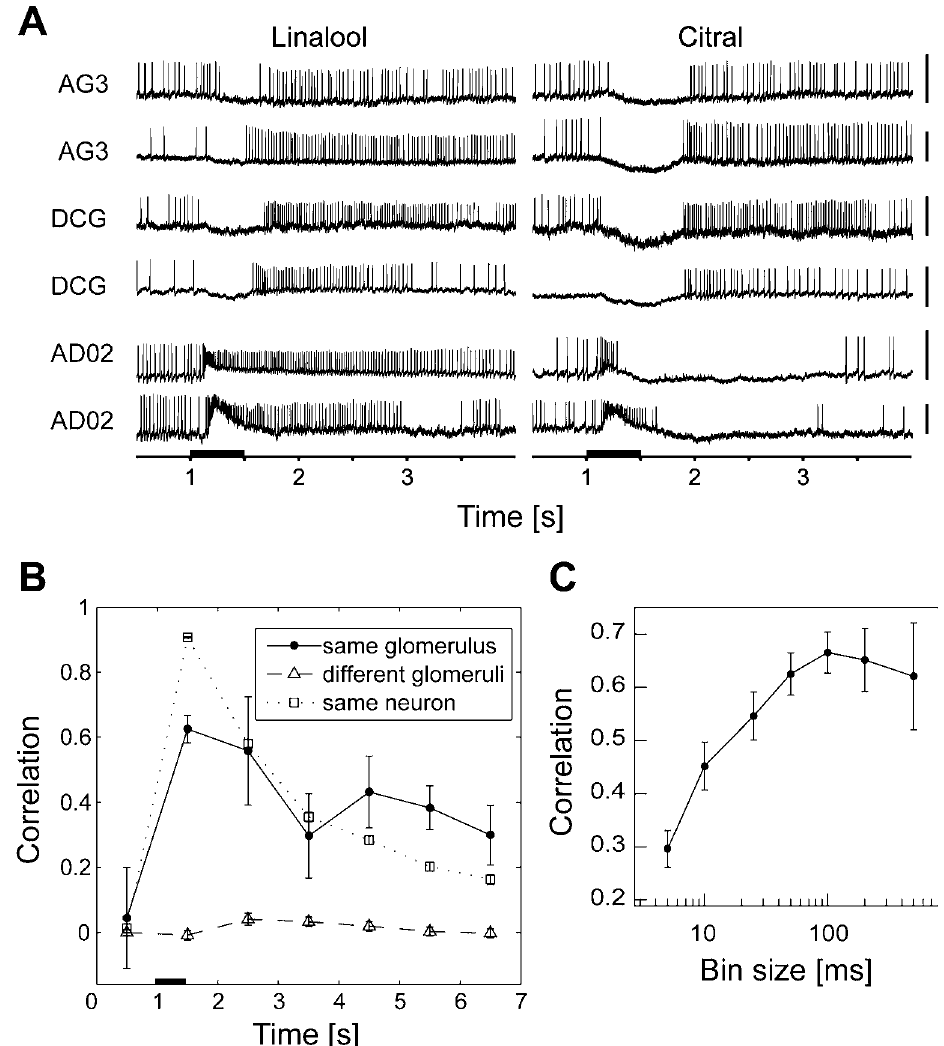
Figure 3 | Odor-evoked temporal profi les of PNs that innervate the same glomerulus are signifi cantly alike . (A) Olfactory responses of three pairs of PNs innervating the glomeruli, AG3, DCG, and AD02. Each trace shows the response to the fi rst applications of linalool and citral. Scale bars = 10 mV. (B) Pearson correlation coeffi cient as a function of time. The graph shows temporal changes in the correlation coeffi cient of the fi ring rate of the bins from 1 s before stimu- lus onset, in steps of 1 s. The black bar represents stimulus duration (500 ms). The black and gray solid lines represent the correlation of fi ring rates of pairs of PNs innervating the same glomerulus ( n = 7 pairs from 11 neurons) and different glomeruli ( n = 554 pairs from 34 neurons), respectively. The broken line represents the correlation of fi ring rates of pairs of responses from the same neurons in different trials ( n = 780 pairs from 45 neurons). Pairs innervating the same glomerulus showed signifi cantly correlated fi ring rates after stimulus onset ( p < 0.01, Student’s t -test). (C) Correlation between PNs innervating the same glomerulus as a function of bin size. We calculated the Pearson correlation coeffi cients of fi ring rates with different bins (5, 10, 25, 50, 100, 200, and 500 ms). Responses to three odors were used for the